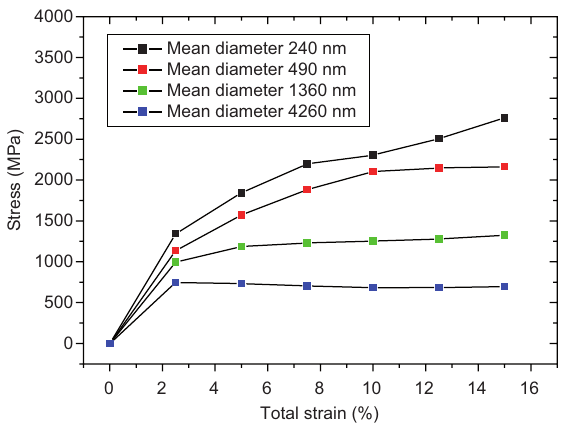
Figure 2 Average deformation curves of Mo micropillars and nanopillars of different diameters. Each curve represents an average of eight samples. Data from [1, 2].